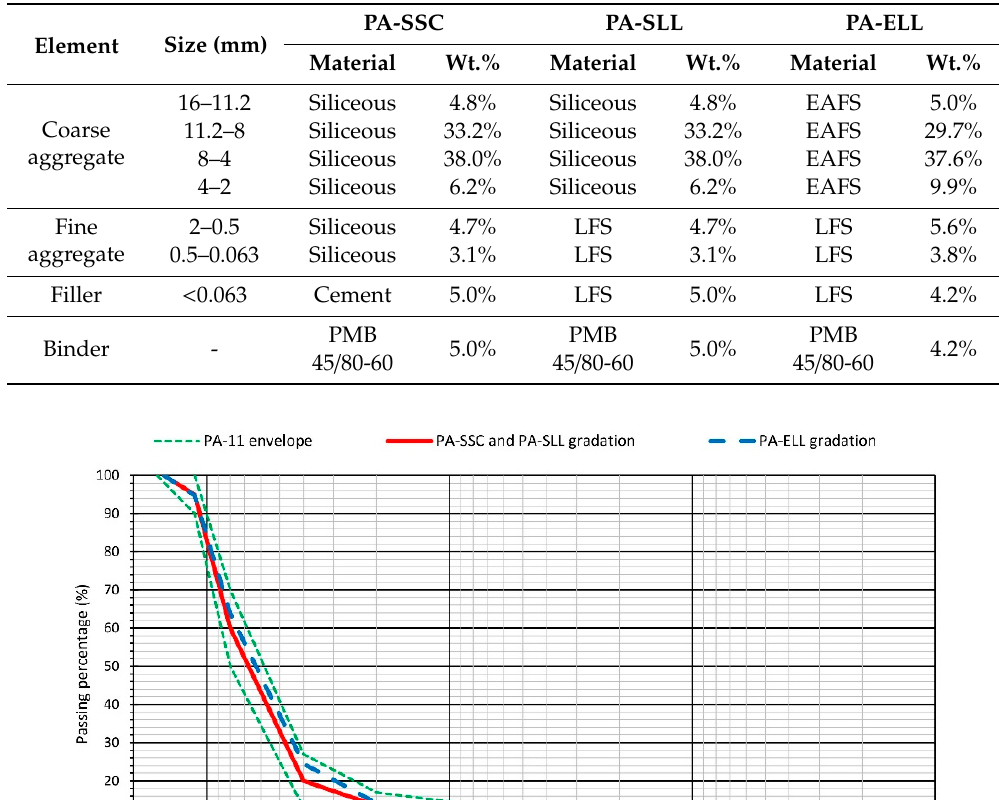
Table 4. Final mix design.